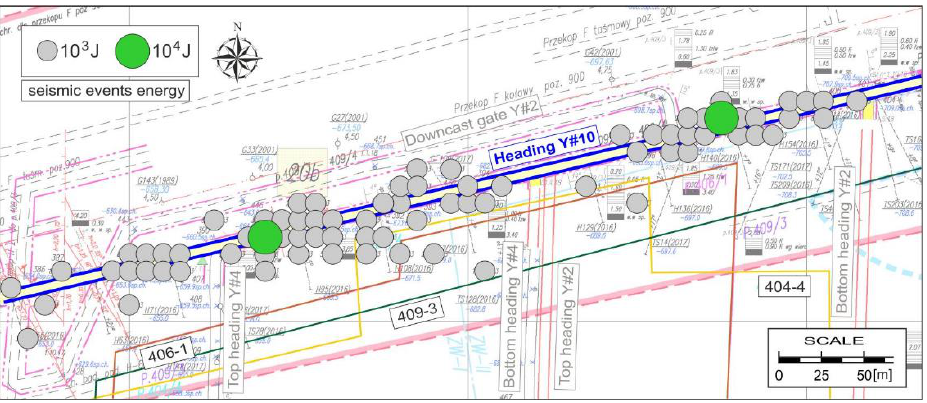
Figure 3. Distribution of seismic events with energy E ≥ 10 3 J during the drifting of heading Y#10. Downcast gate Y#2. Seismic activity registered during the drifting operations was on